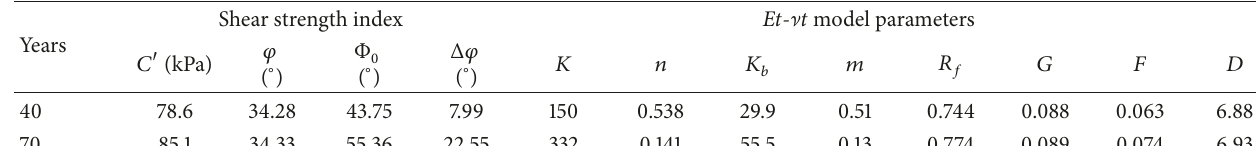
Table 8: Et- ] t model parameters.